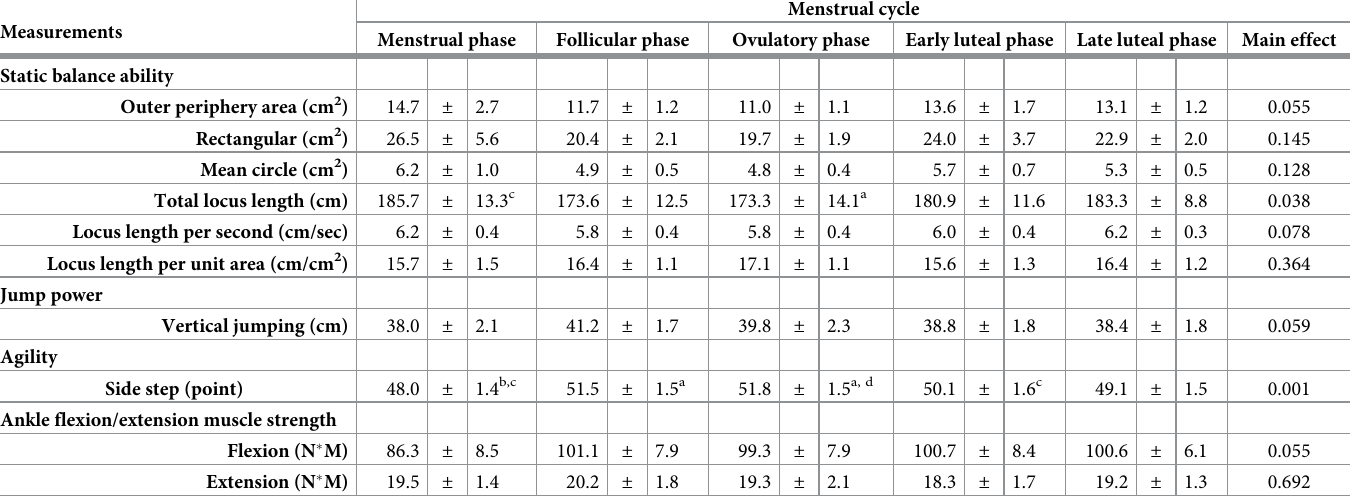
Table 3. Variations in the athletic performance indexes over the menstrual